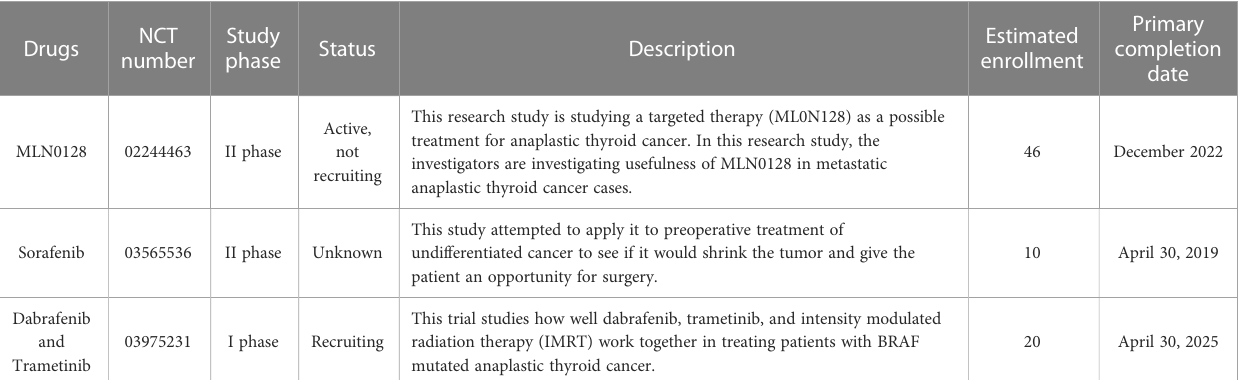
TABLE 1 Ongoing clinical trials of targeted therapy for